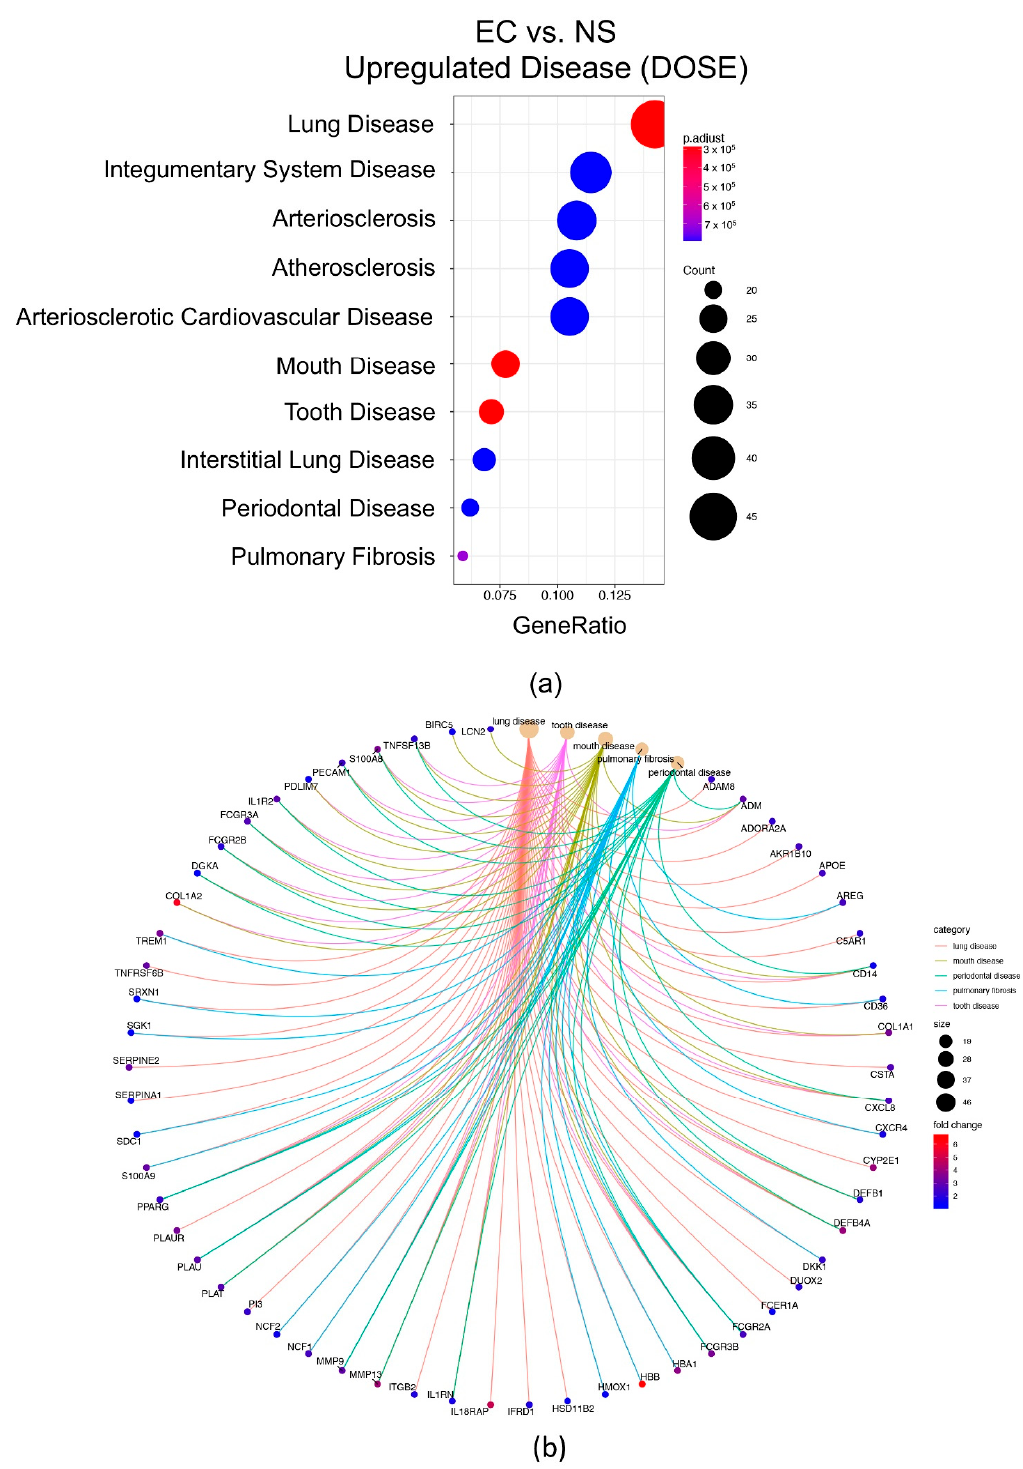
Figure 7. Disease Ontology Semantic and Enrichment (DOSE) analysis for upregulated genes in the EC vs. NS set. ( a ) Diseases plotted vs. gene ratio. Circles represent gene number associated with each disease and color represents the adjusted p -values. ( b ) Top enriched diseases in the EC vs. NS set include the respiratory system. Diagram shows the DEGs associated with each disease and their fold changes (color key on right). The circle size key indicates the number of genes associated with each disease. Images can be enlarged to read